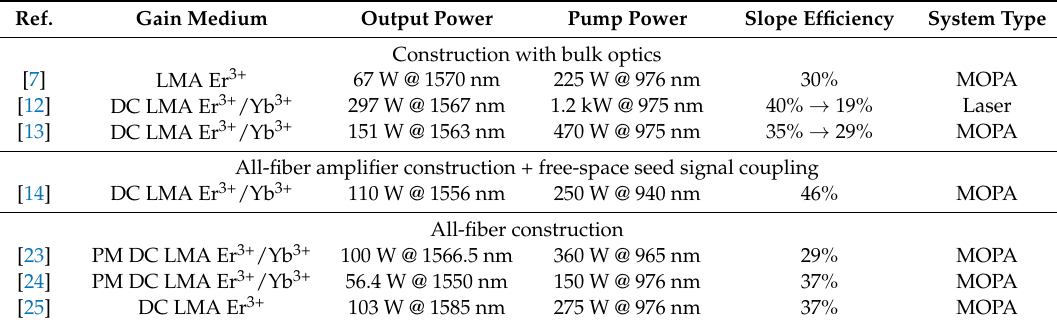
Most important parameters of mentioned MOPA (master oscillator power amplifier)/laser